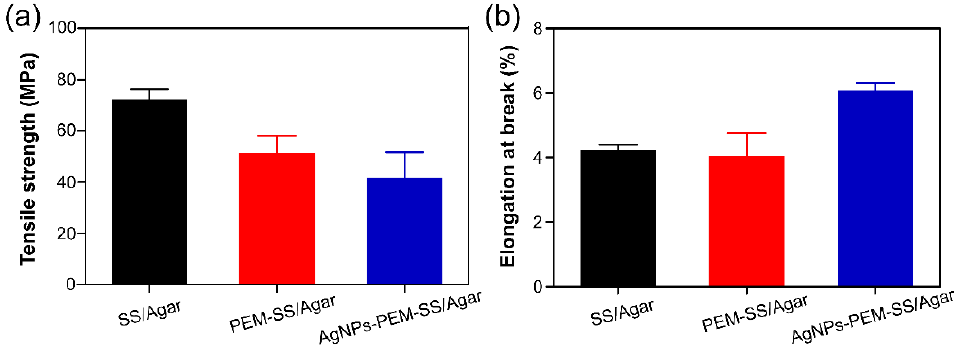
Figure 6. Mechanical properties of the films: ( a ) tensile strength and ( b ) elongation at break.